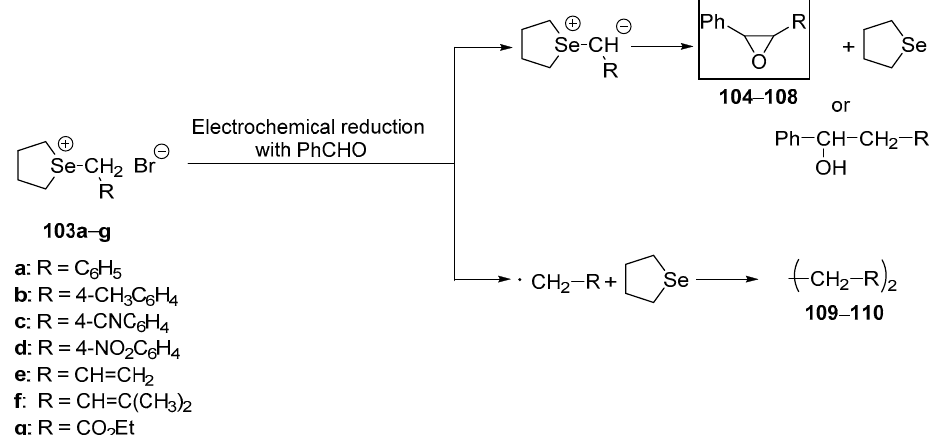
Table 7. Electrochemical reduction of substituted methyltetrahydroselenonium bromide 103a – g in the presence of benzaldehyde.